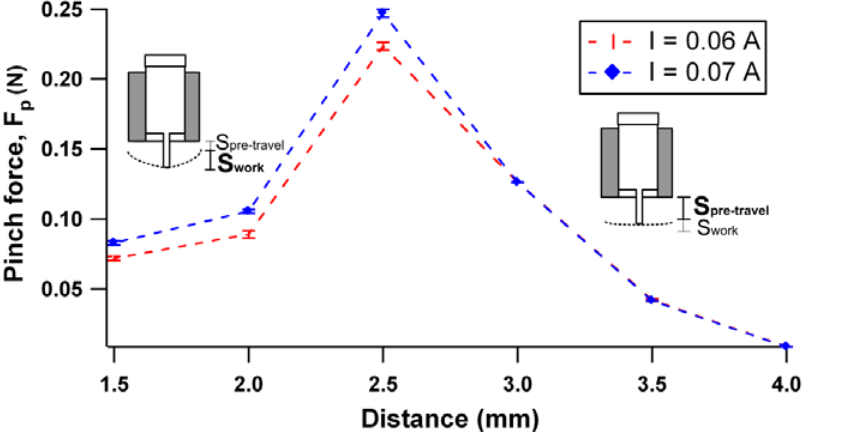
Figure 8. Pinch force exerted on the membrane with gap separation